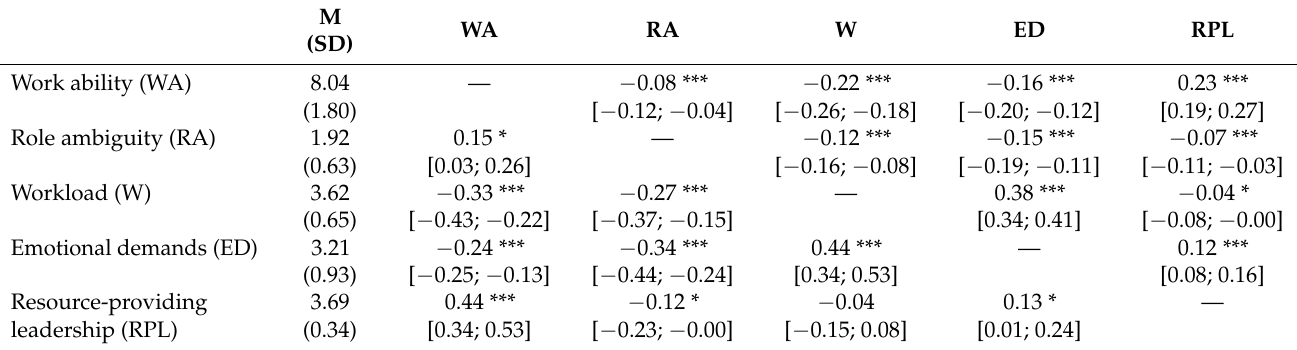
Table 1. Descriptive statistics of the study variables and sample with 95% CI.